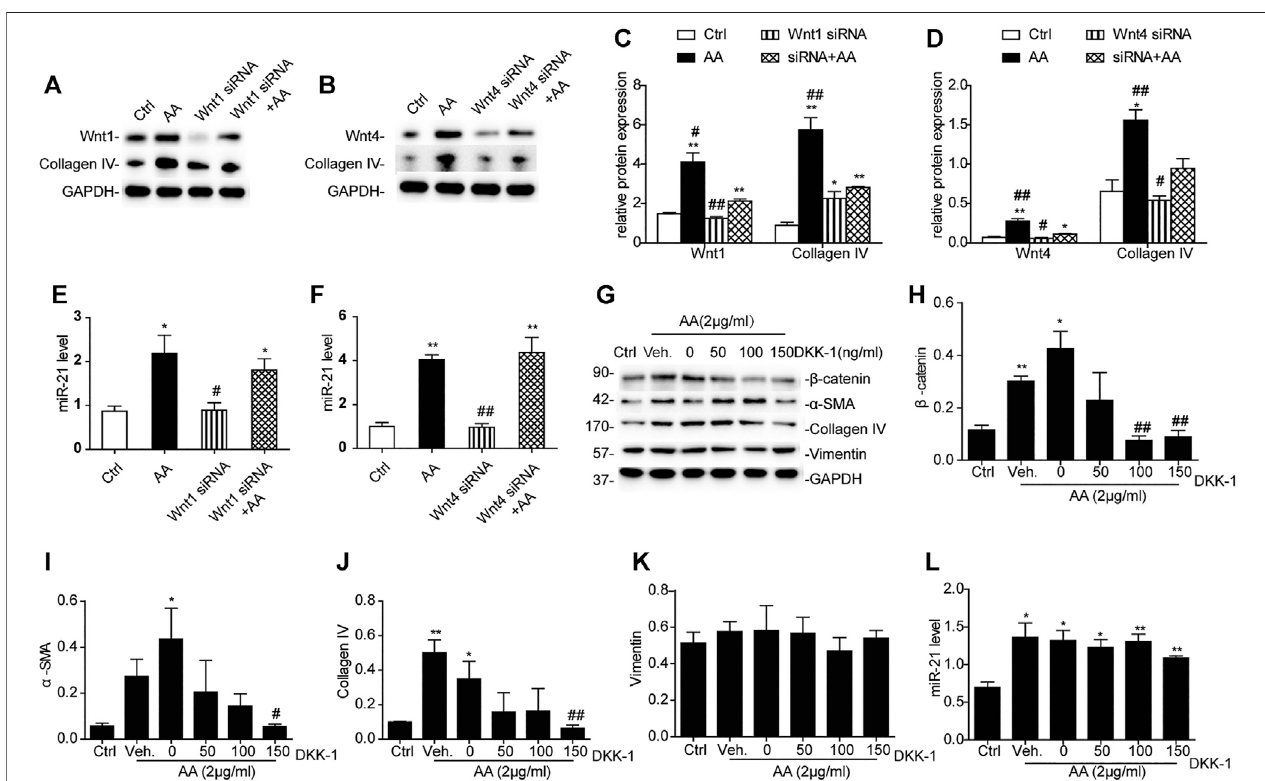
FIGURE6| InhibitionofWnt1/4-mediated β -cateninpathwayspartiallyreversesAA-mediated fi brogenesisinHK-2cells. (A – F) RelativeproteinexpressionofWnt1, Wnt4,andcollagenIVandmiR-21expressioninHK-2cellstreatedwithWnt1siRNAorWnt4siRNA6 hpriortoAAstimulation(2 μ g/ml)for48 h* p < 0.05and** p < 0.01 vs. controls. # p < 0.05 and ## p < 0.01 vs. Wnt1 siRNA + AA or Wnt4 siRNA + AA, n (cid:2) 3. (G – L) RT-qPCR results of miR-21 abundance and changes in protein abundances of the indicated proteins in HK-2 cells treated with DKK-1 at 50, 100, or 150 ng/ml 1 h prior to AA stimulation (2 μ g/ml) for 48 h * p < 0.05 and ** p < 0.01 vs. controls. # p < 0.05 and ## p < 0.01 vs. vehicle controls (Veh), n (cid:2)